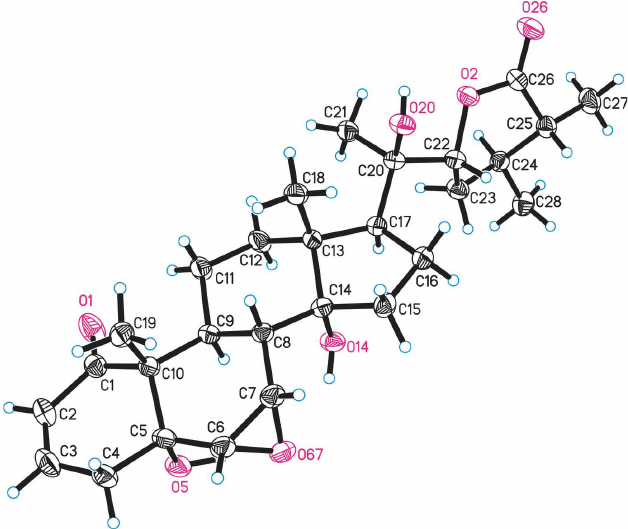
Figure 2 Molecular structure of the 14 (cid:2) -hydroxyixocarpanolide (compound II ), including atom labelling. Displacement ellipsoids are drawn at the 30% probability level.